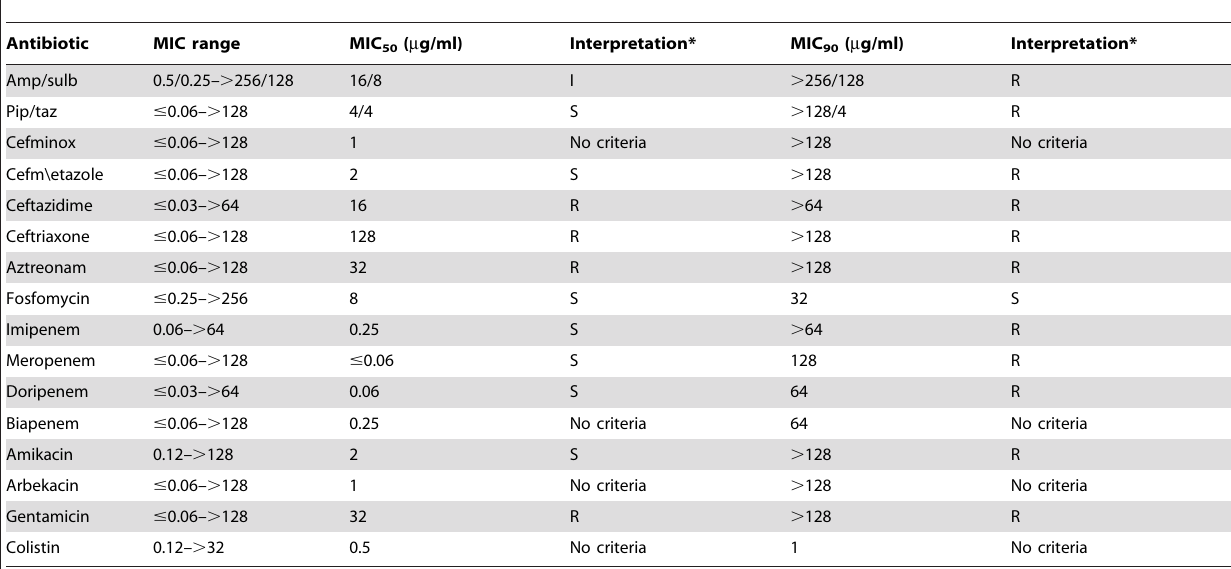
Table 3. Determination and interpretation of the MIC values of the antibiotics tested for Klebsiella spp. (n= 207).